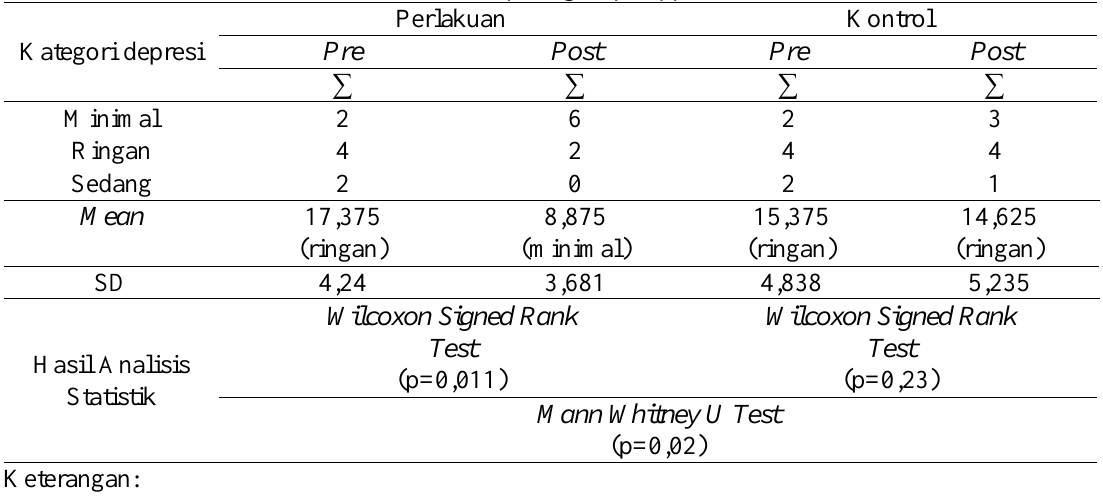
Tabel 1. Tingkat depresi sebelum dan setelah peer group